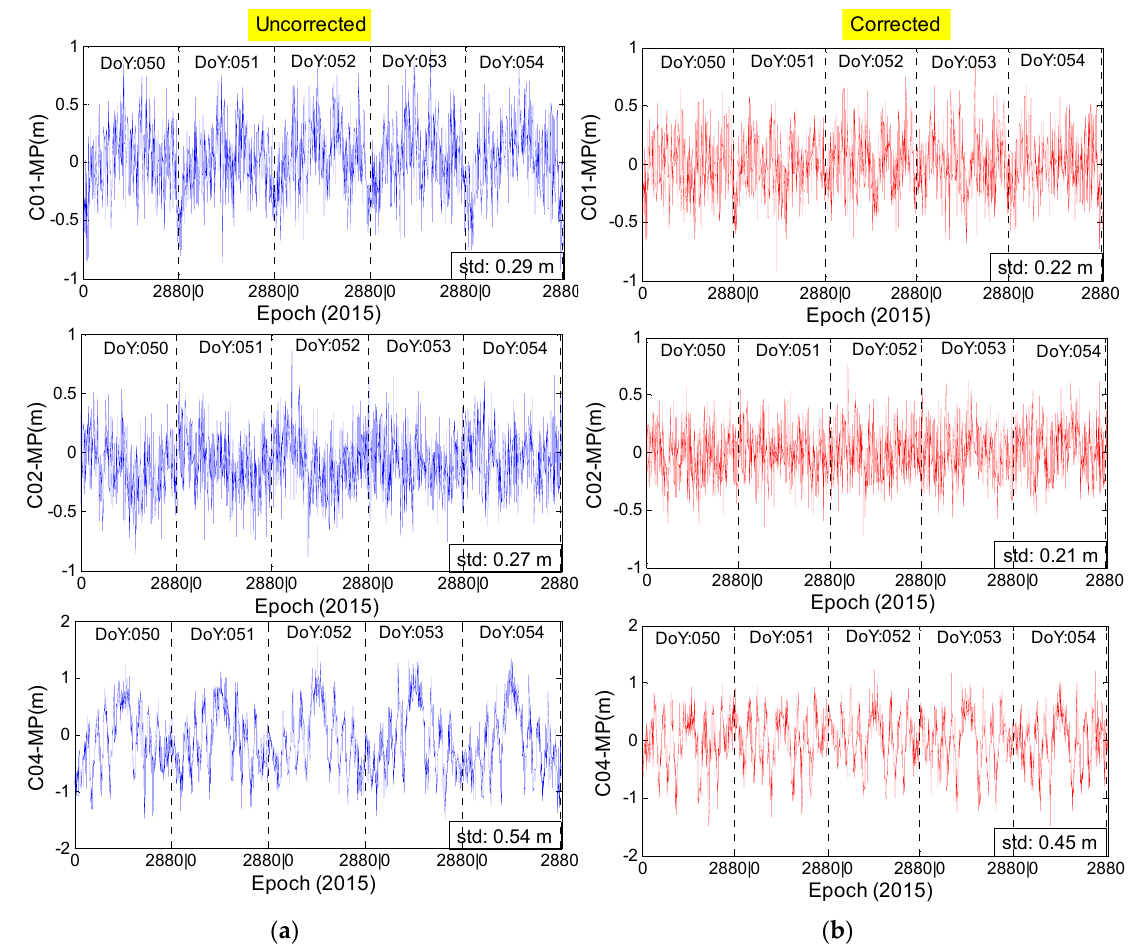
Figure 15. The multipath estimations of the second frequency without ( a ) and with ( b ) corrections for code bias. “std” represents the standard deviations of multipath series.